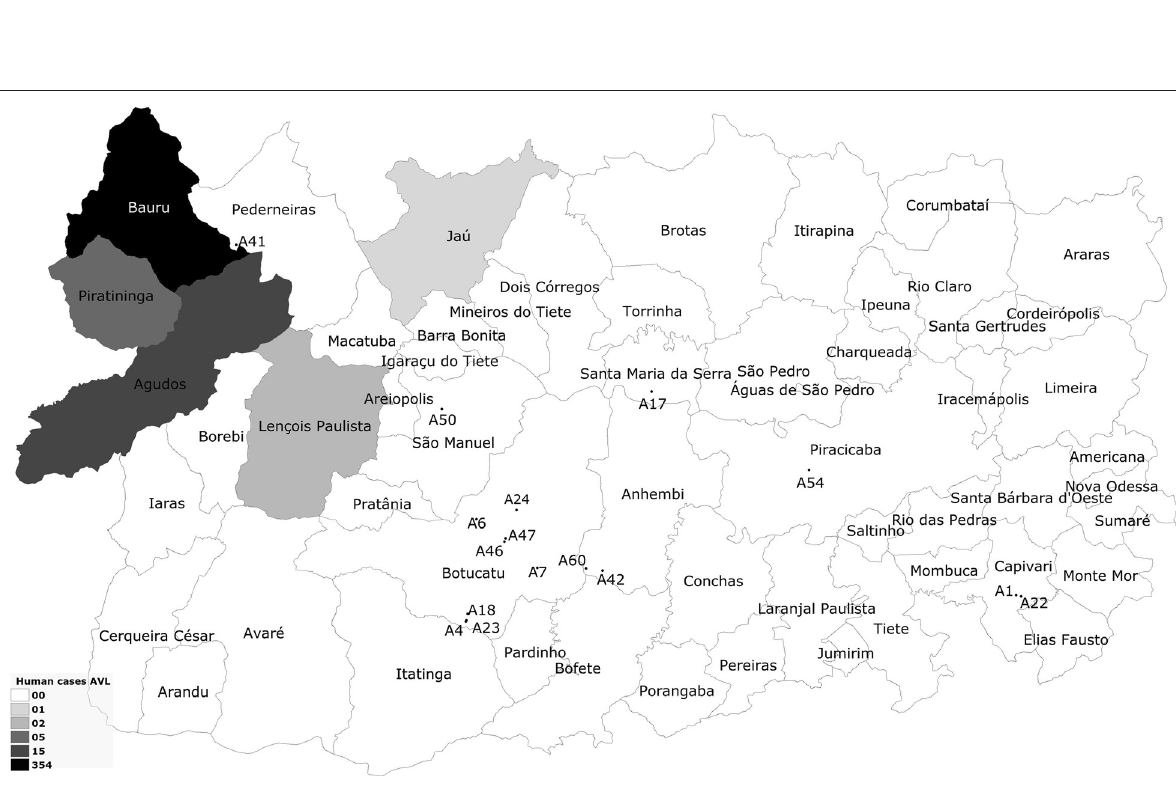
Figure 2 Geographic location of the road-killed animals employed for Leishmania spp. molecular detection, correlating to the occurrence of cases of human visceral